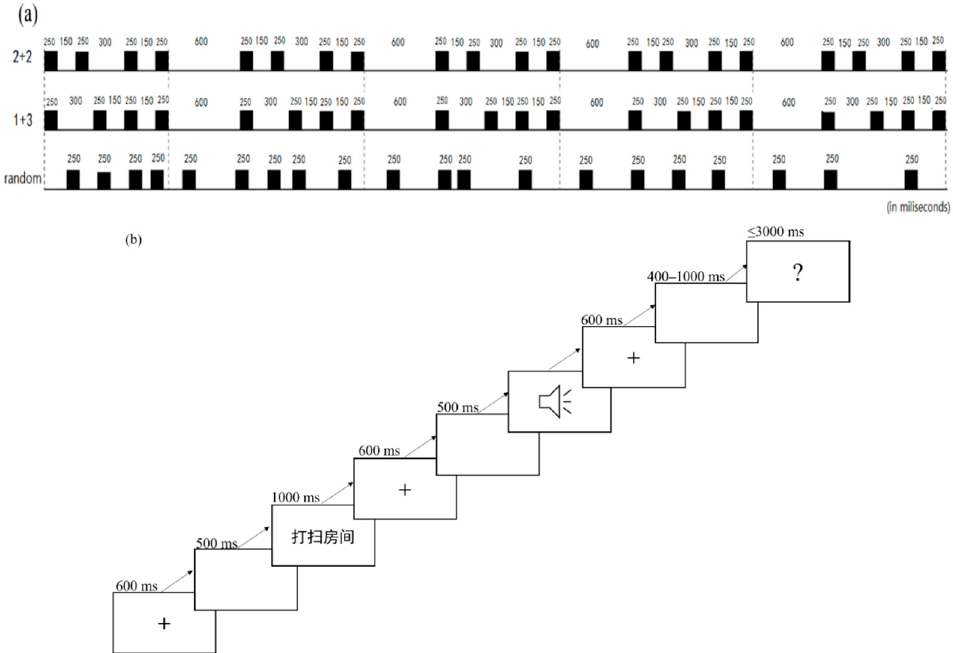
Figure 1. ( a ) Rhythmic patterns for primes (2+2 primes have a longer time interval between the second and third pure tone; 1+3 primes have a longer time interval between the first and second pure tone; random primes do not have a fixed time interval between tones). ( b ) A schematic of a